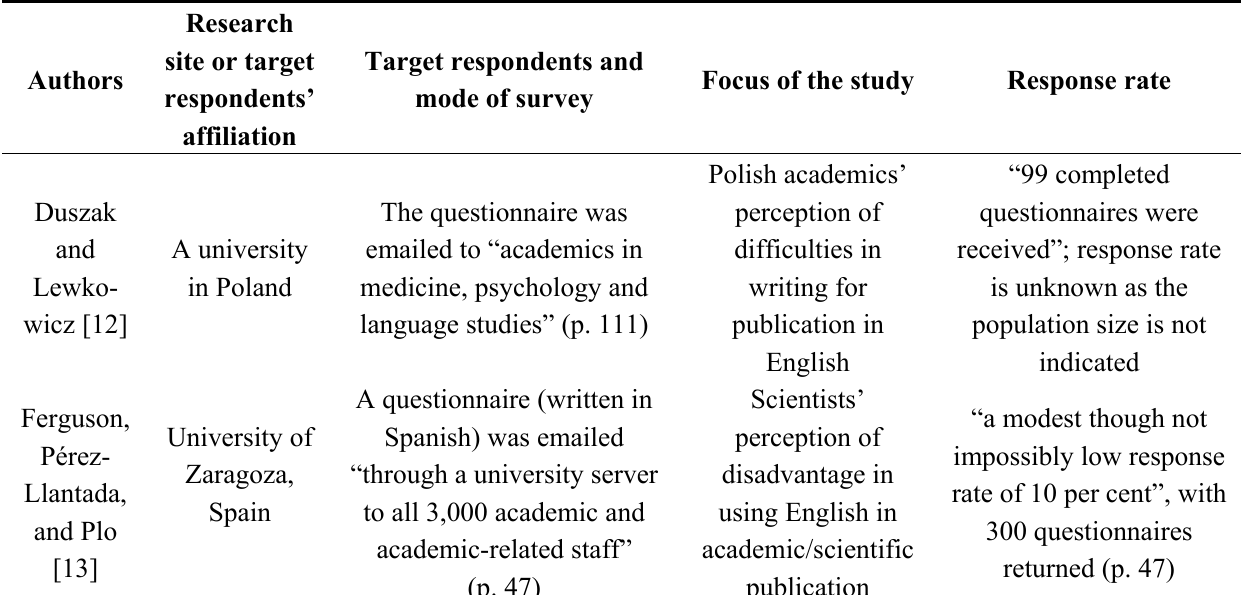
Table 2. A summary of five surveys conducted by language professionals in European